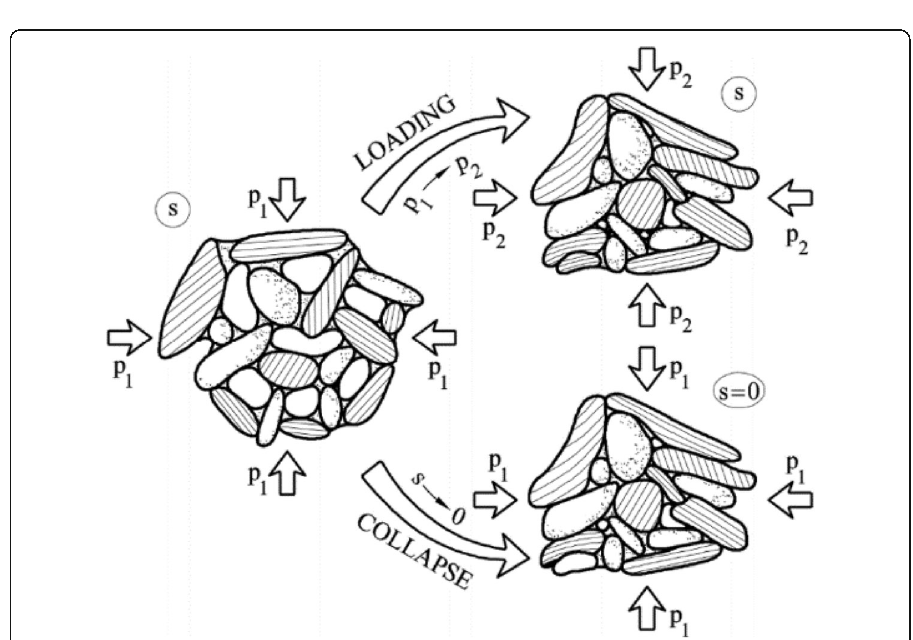
extent the effective stress concept to cover unsaturated soils based on three types of stress variable; attempts to combine pore air pressure, pore water pressure, and total stress within a single effective stress variable. A notable Eq. (3) based on two stress states (net stress and matric suction) (Fig. 5) and a soil parameter ( χ ) was proposed by Bishop [10].